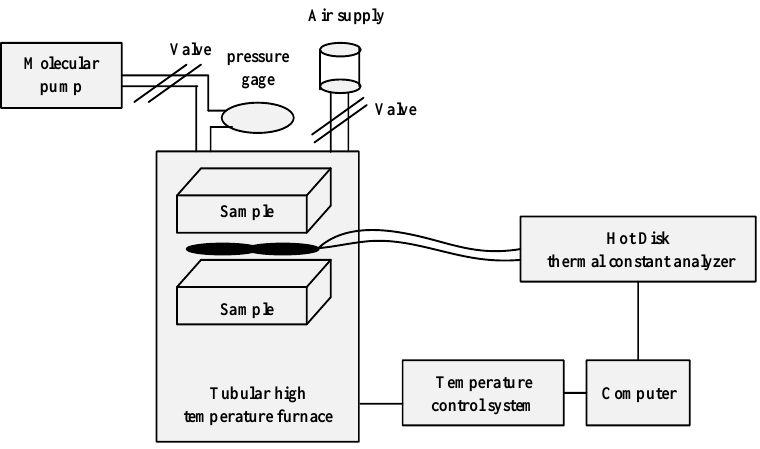
Figure 4. The schematic diagram of thermal conductivity measurement.